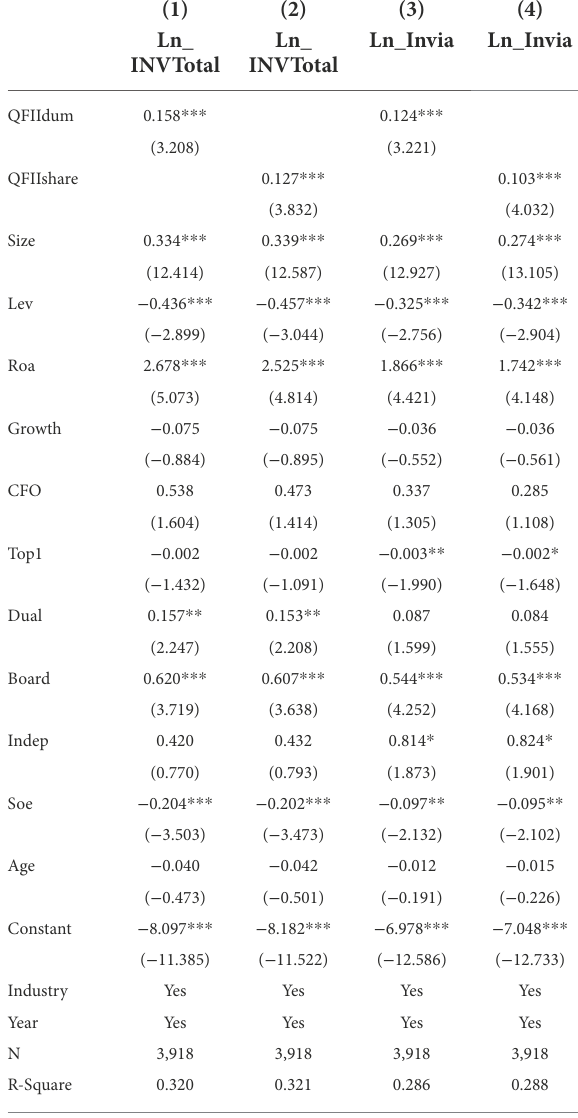
TABLE 7 Robustness test: The impact of QFII on the quantity and quality of corporate innovation—a PSM pair-based